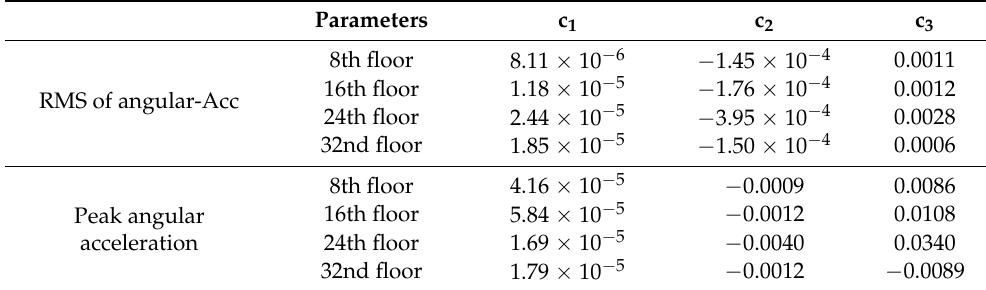
Table 3. The fitting results of torsional parameters of c 1 and c 2